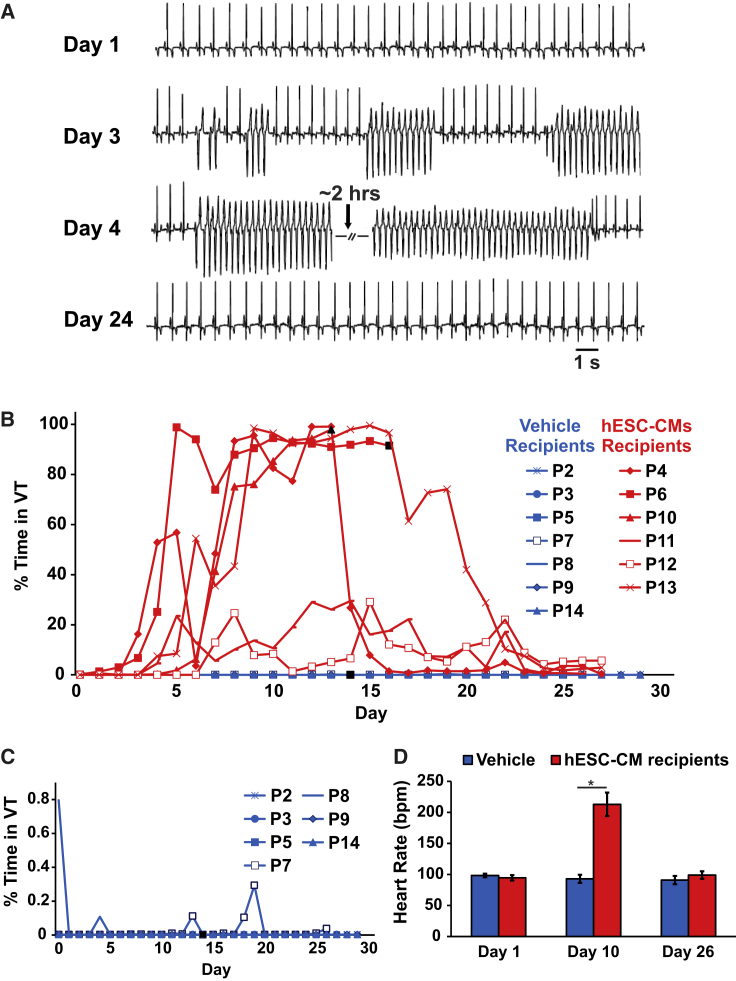
hESC-CM Transplantation Results in Ventricular TachyarrhythmiasInfarcted animals receiving either hESC-CM or vehicle were continuously monitored by telemetric ECG for spontaneous arrhythmias.(A) Representative ECG traces from a hESC-CM recipient acquired on days 1, 3, 4, and 24 post transplantation.(B) Plot depicting the fraction of each day spent in VT in vehicle (blue; n = 7) and hESC-CM (red; n = 6) recipients by time point post transplantation. Pigs that either died or were sacrificed prematurely (P5, P6, and P10) are indicated with a black terminal symbol.(C) By comparison, vehicle recipients showed either no VTs or rare episodes lasting only a few seconds in duration, so a different ordinate axis is required to visualize VT incidence in these animals.(D) Mean heart rate in hESC-CM versus vehicle recipients on days 1, 10, and 26 post transplantation. n = 3 for vehicle and hESC-CM recipients. ∗p < 0.01.